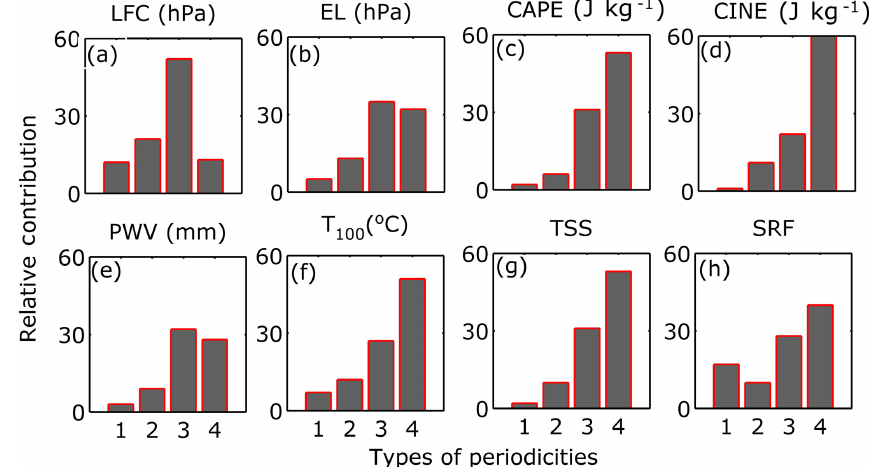
Figure 7. Percentage contribution of various periodicities to the long-term trend of all instability parameters over India, namely (1) 1.5–2.5- year periodicity, (2) 4–6-year periodicity, (3) 10–12-year periodicity, and (4) 16–20-year